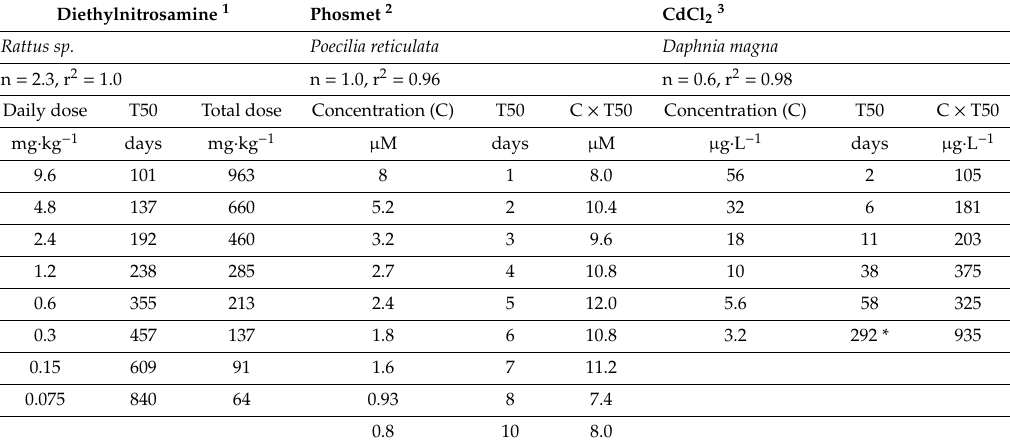
Table 2. The three patterns of chemical toxicity with time of exposure as identified by the total dose or C × T50. The carcinogen diethylnitrosamine shows time-cumulative toxicity in rats. The organophosphorus insecticide phosmet shows time-dependent toxicity that complies with Haber’s rule. Toxicity of the reagent cadmium chloride is mainly dose-dependent.